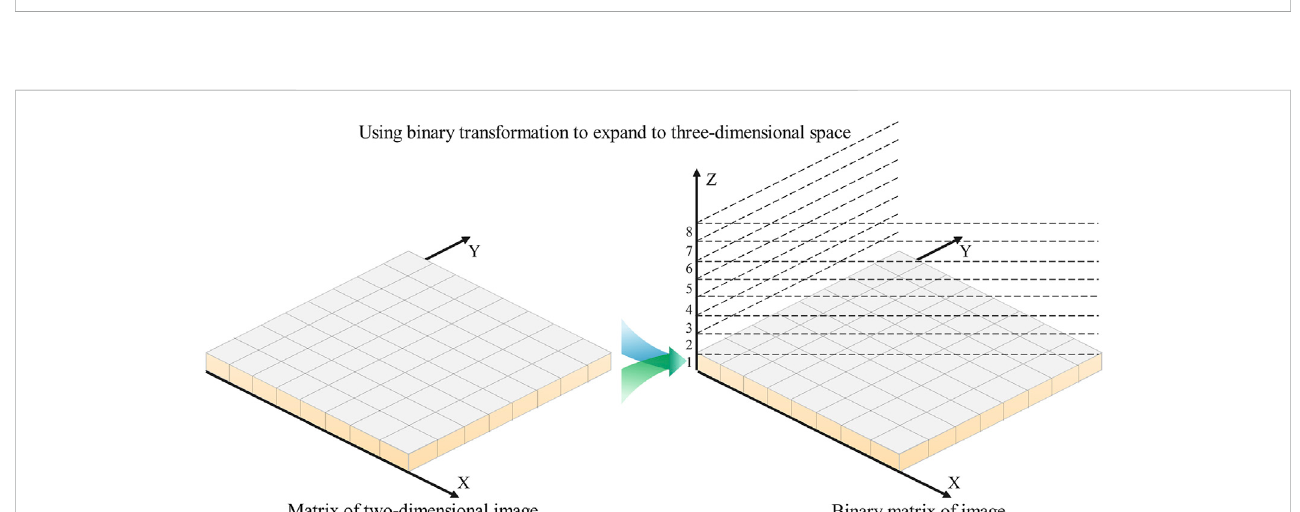
FIGURE 2 The bitwise expansion of a two-dimensional decimal matrix extended to a three-dimensional space to construct an eighth-order Rubik ’ s cube-like.